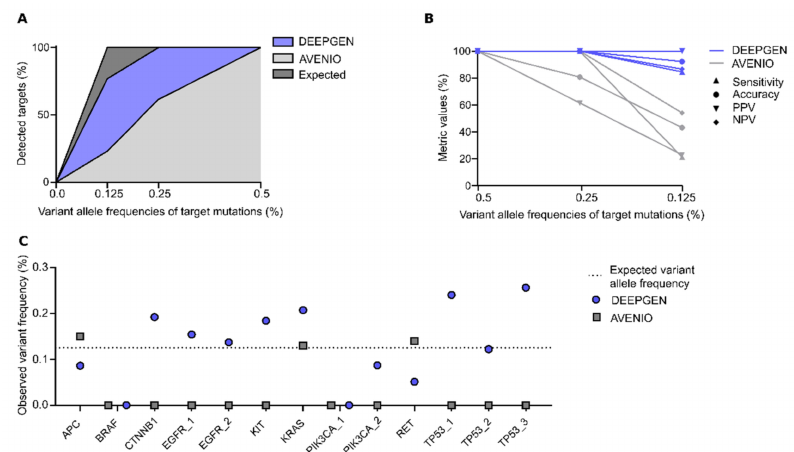
Figure 5. Comparison of DEEPGEN TM and the AVENIO assay using 13 validated targets with known VAF. ( A ) Coloured areas represent the fraction of targets detected by DEEPGEN TM (violet) and AVENIO (light grey) at 0.125%, 0.25% and 0.5% VAF. ( B ) Specificity, sensitivity, PPV, NPV and accuracy for DEEPGEN TM and AVENIO assays for each tested VAF. ( C ) Overview of all 13 overlapping targets (at 0.125% VAF) with their measured variant frequencies from the AVENIO and DEEPGEN TM